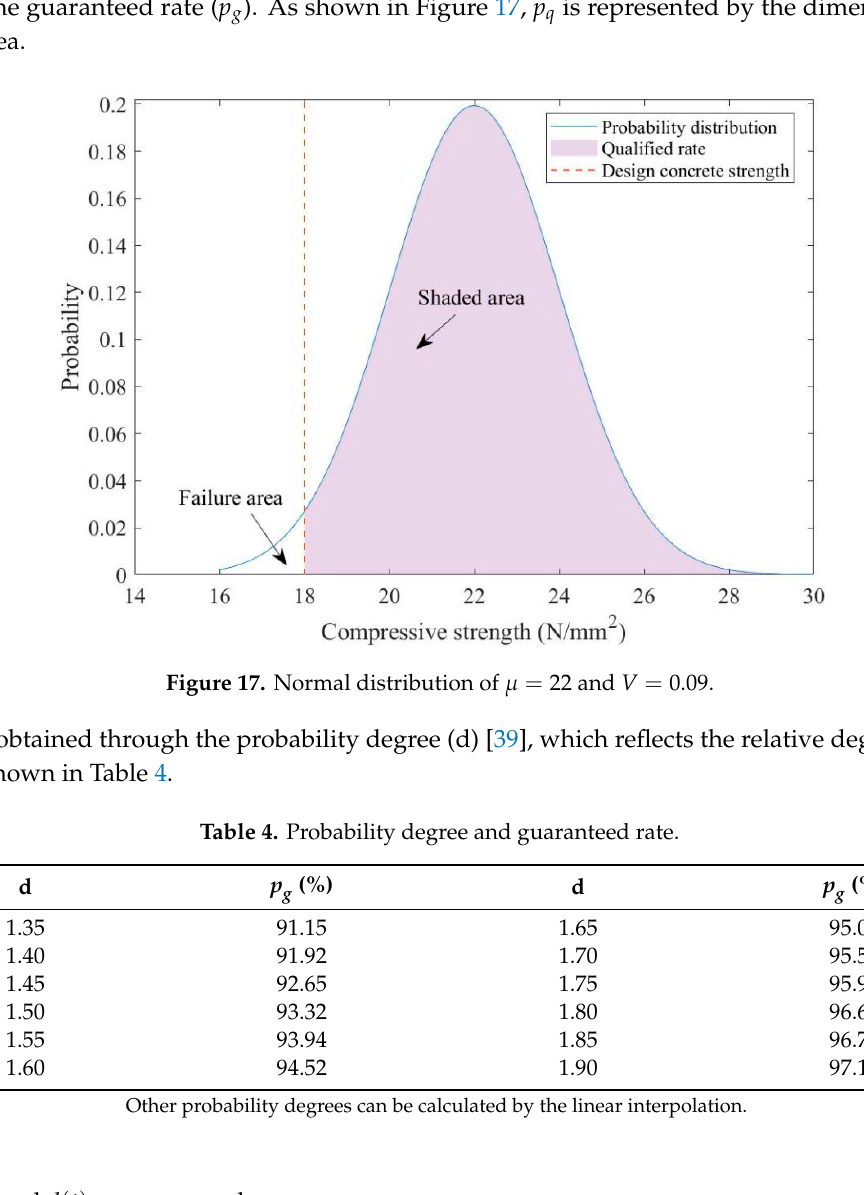
Figure 16. Time-varying reliability index and MC simulation (